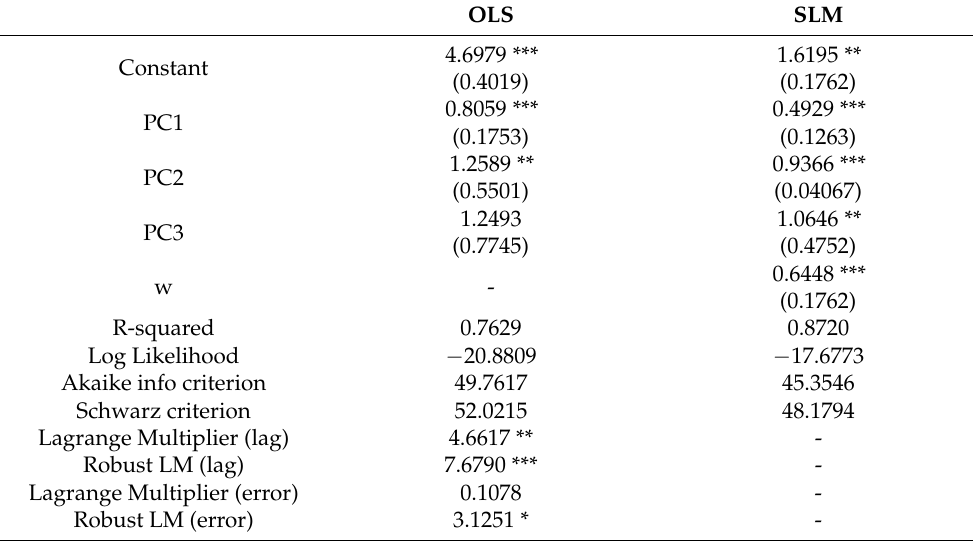
Table 6. Summary statistics of OLS and SLM in modeling COVID-19 morbidity rate with the principal